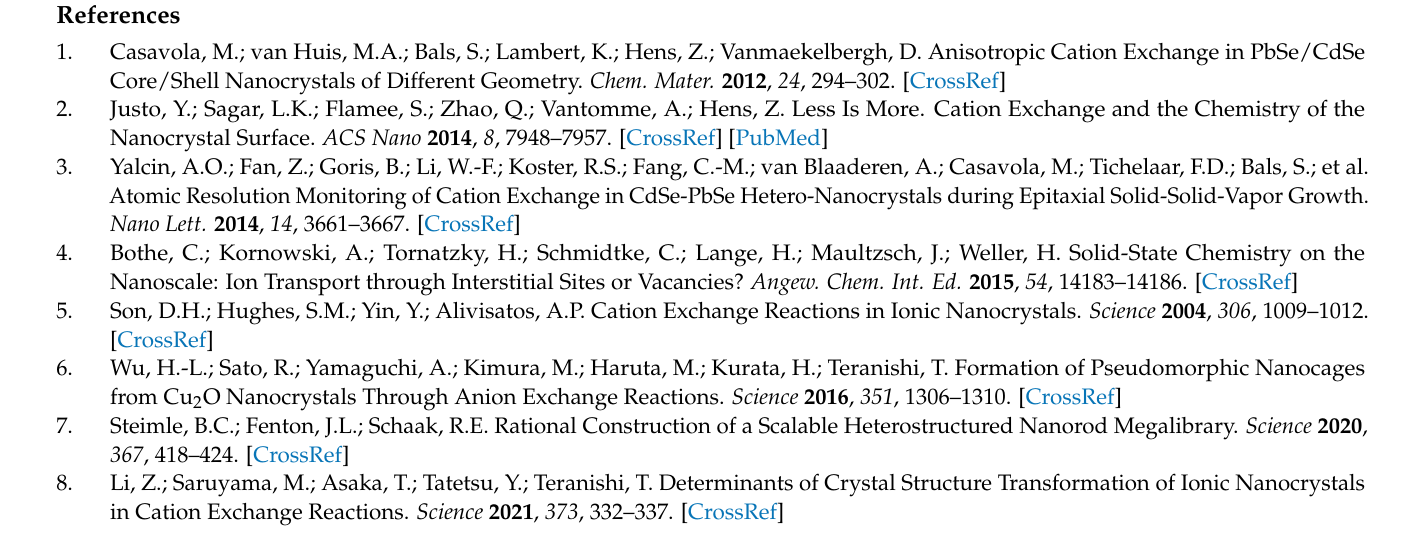
Table S8: DFT-calculated formation enthalpies ∆ H 1 and ∆ H 2 evaluated for pure SnSe and Sb-doped SnSe